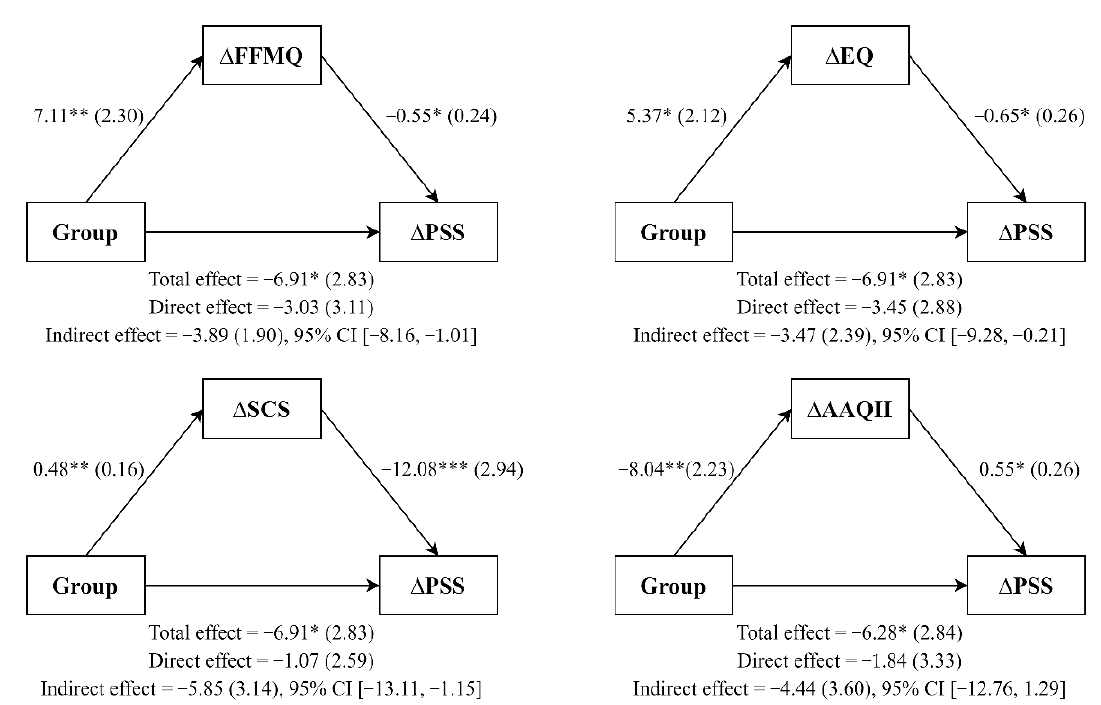
Figure 2. Simple mediation analyses. Note. All coefficients represent unstandardized regression coefficients (standard errors in brackets). * p < 0.05; ** p < 0.01; *** p < 0.001.